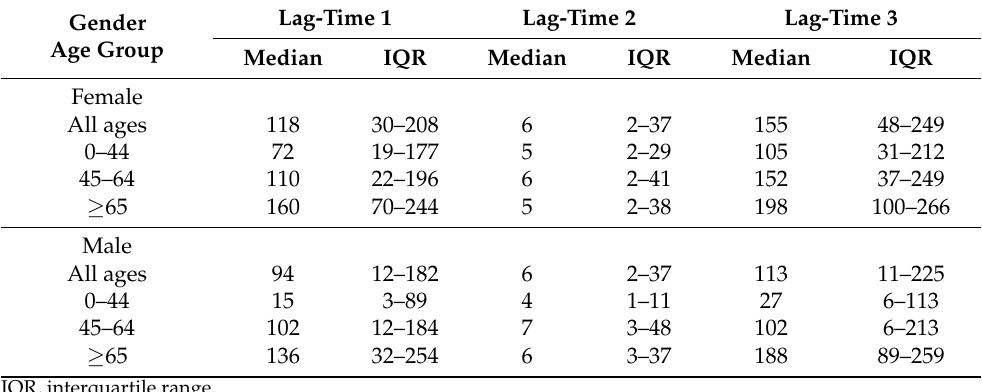
Table 2. Three items of the diagnostic delay in primary Sjögren’s syndrome (unit: weeks).